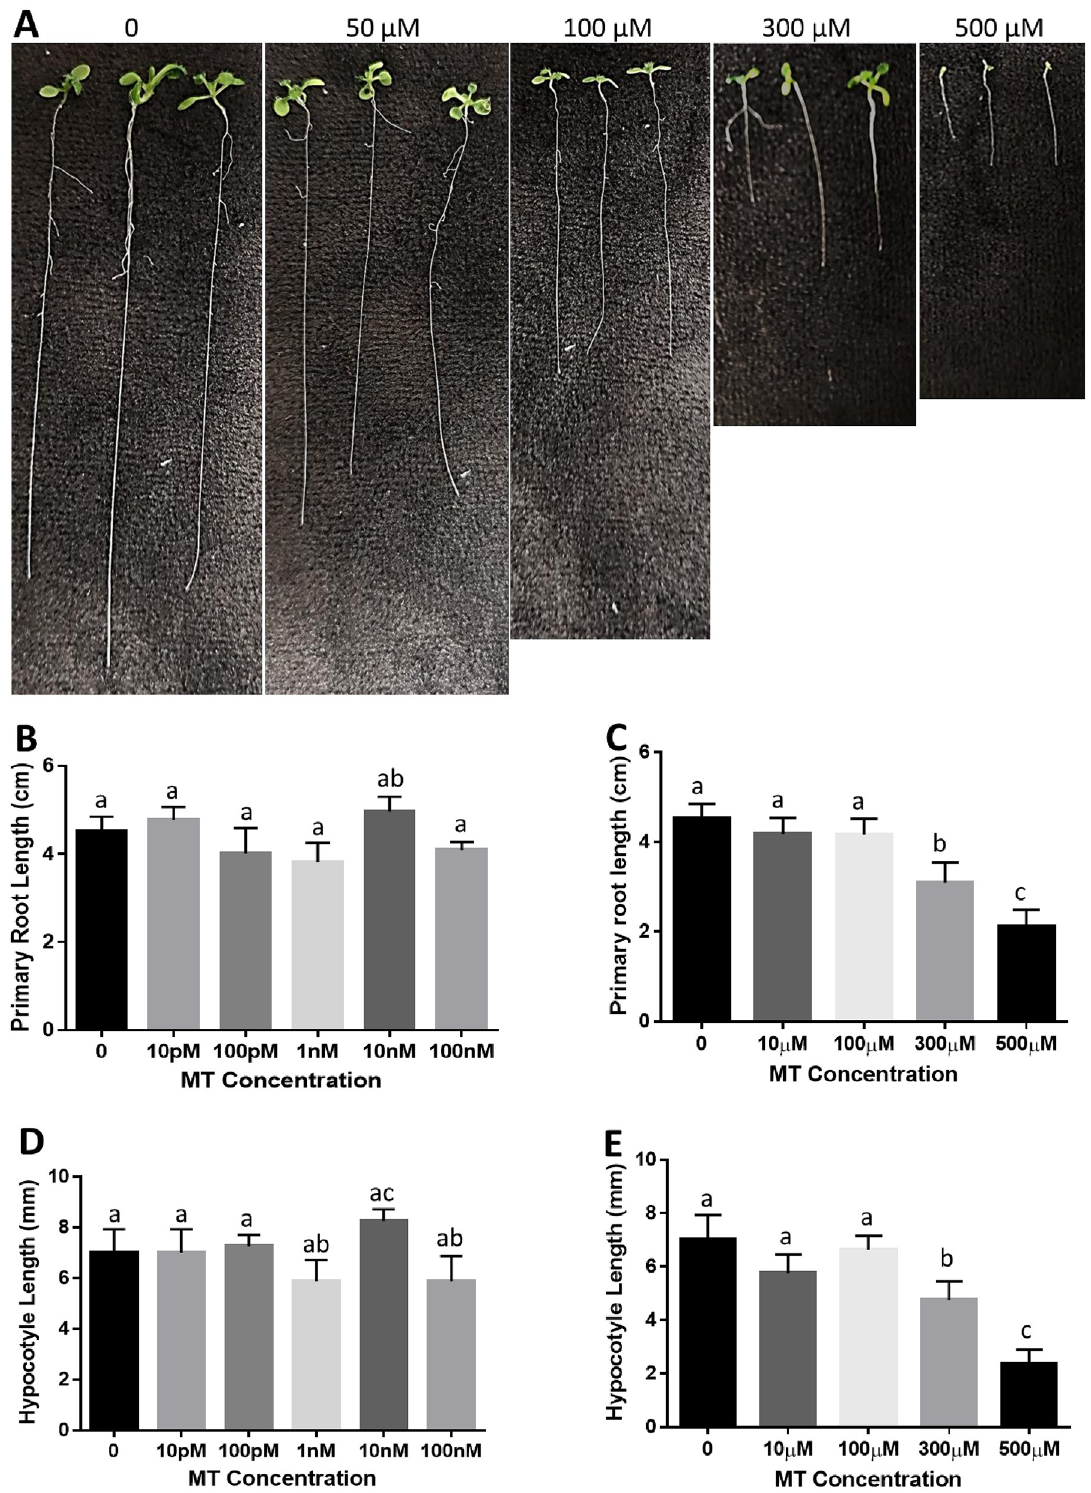
Fig 2. Effect of melatonin on Arabidopsis primary root length and hypocotyl elongation. Surface sterilized seeds of Arabidopsis ecotype Col-0 were directly germinated and grown on1/2 MS medium with different concentrations of melatonin for 10 days. Length of primary root and hypocotyl were measured. (A) Representatives of primary root length of wild type Arabidopsis seedlings treated with